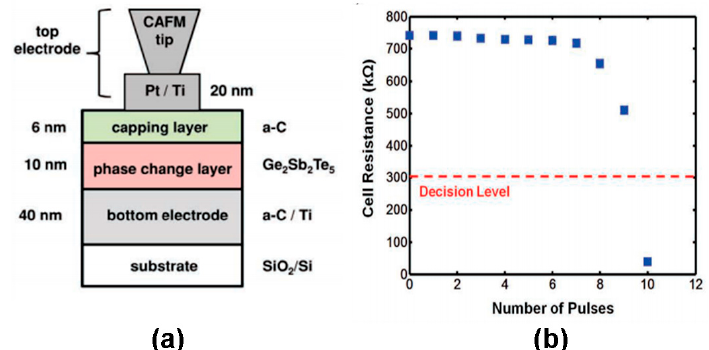
Figure 23. ( a ) Schematic of the phase-change electrical probe memory for arithmetic computing application and ( b ) the resistance of the cell after the application of each of 10 input pulses with each input pulse having an amplitude of 1.085 V and being of 60 ns duration. Reproduced with permission from [53]. Copyright Wiley, 2012.